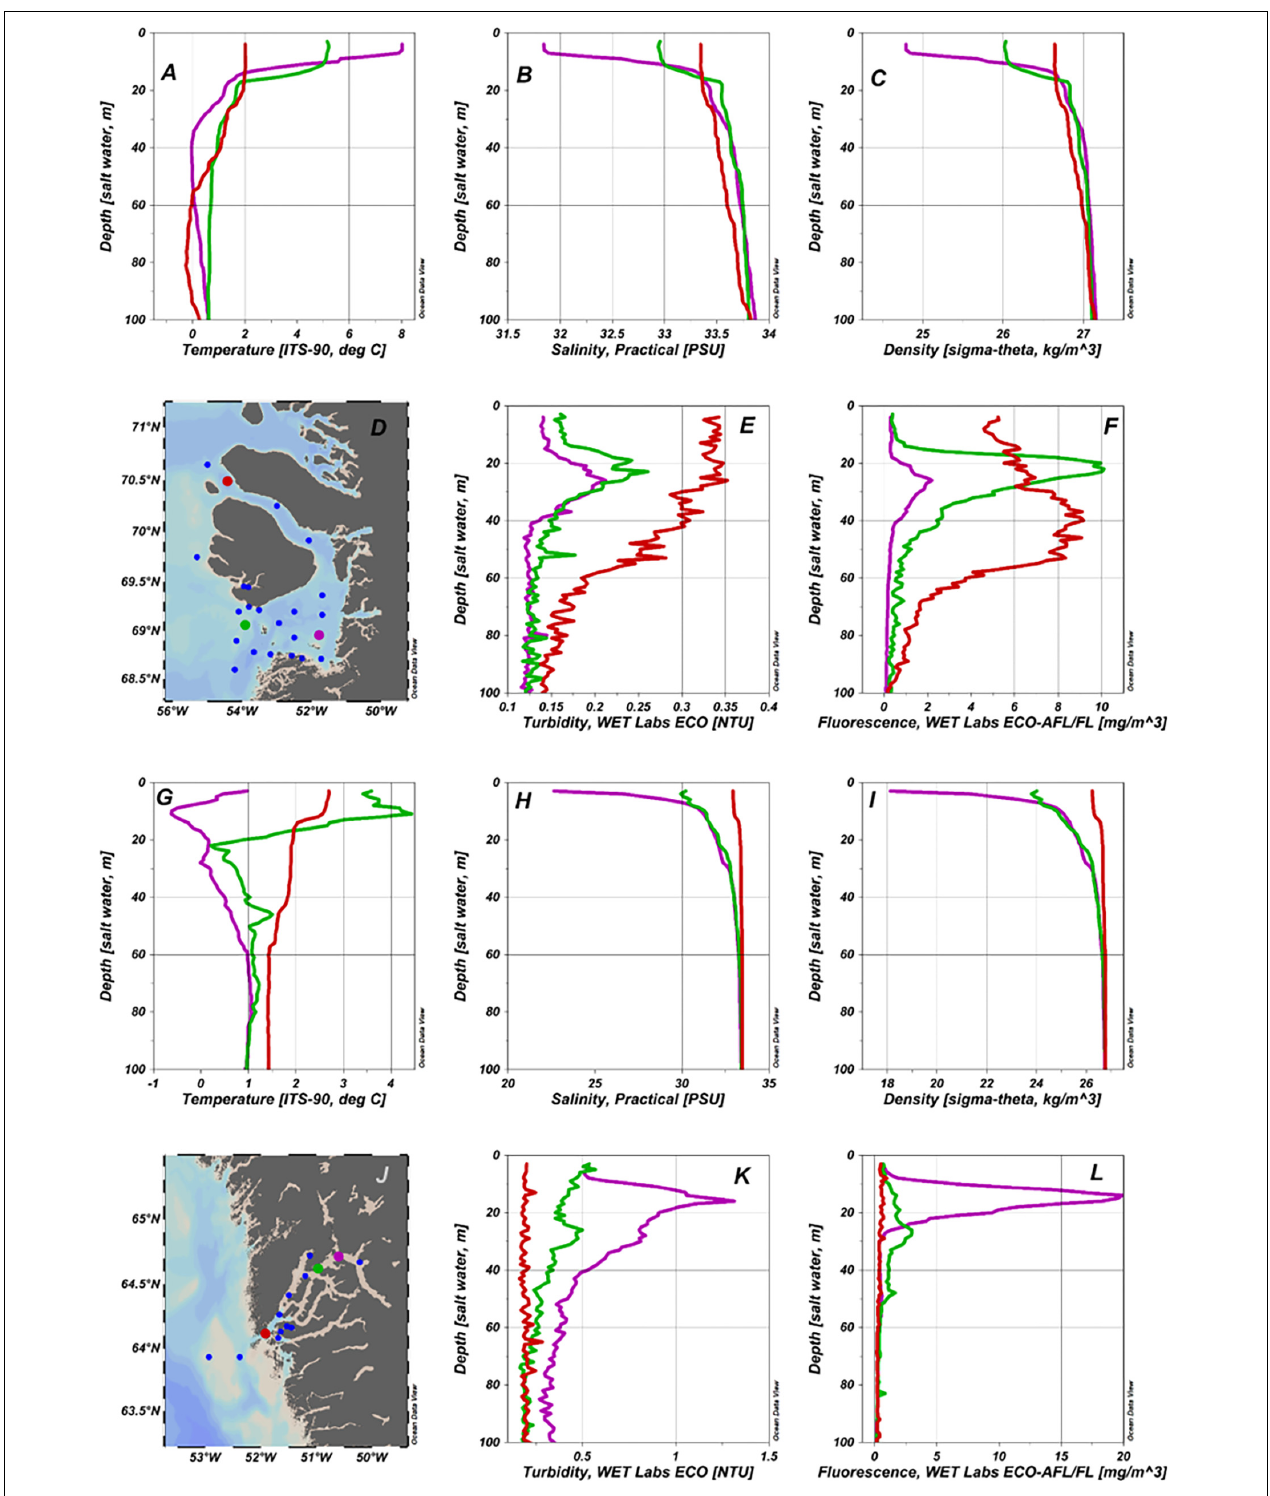
FIGURE 5 | Depth profiles of hydrographic [temperature (A,G) , salinity (B,H) , density (C,I) ] and bio-optical parameters [turbidity (E,K) , Chla fluorescence (F,L) ] at stations representing the three different water masses in the (top panel) Vaigat-Disko Bay and the (bottom panel) Godthabsfjord sections. (D,J) Stations sampled and representative stations marked. Note that ranges in axes are different, representing the observed ranges in the two areas of investigation.